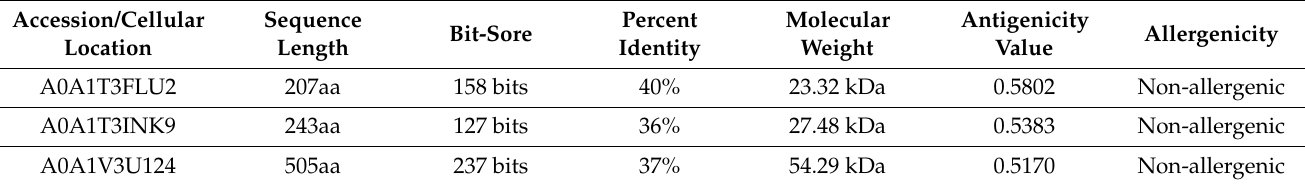
Table 1. The three whole-proteome-based shortlisted proteins of E. meningoseptica with optimal properties for inclusion in immunogen designs. Furthermore, the antigenic and non-allergenic nature of the proteins is also